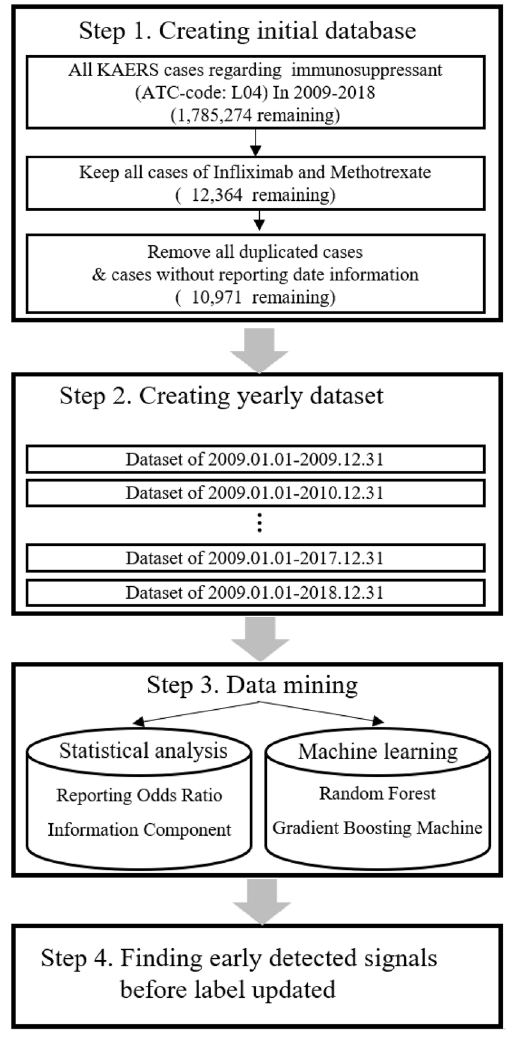
Figure 3. Step-by-step process from dataset construction to evaluation of the data mining methods in detecting early safety signals of infliximab in the KAERS between 2009 and 2018. Abbreviations: KAERS, Korea Adverse Event Reporting System; ATC, Anatomical Therapeutic Chemical